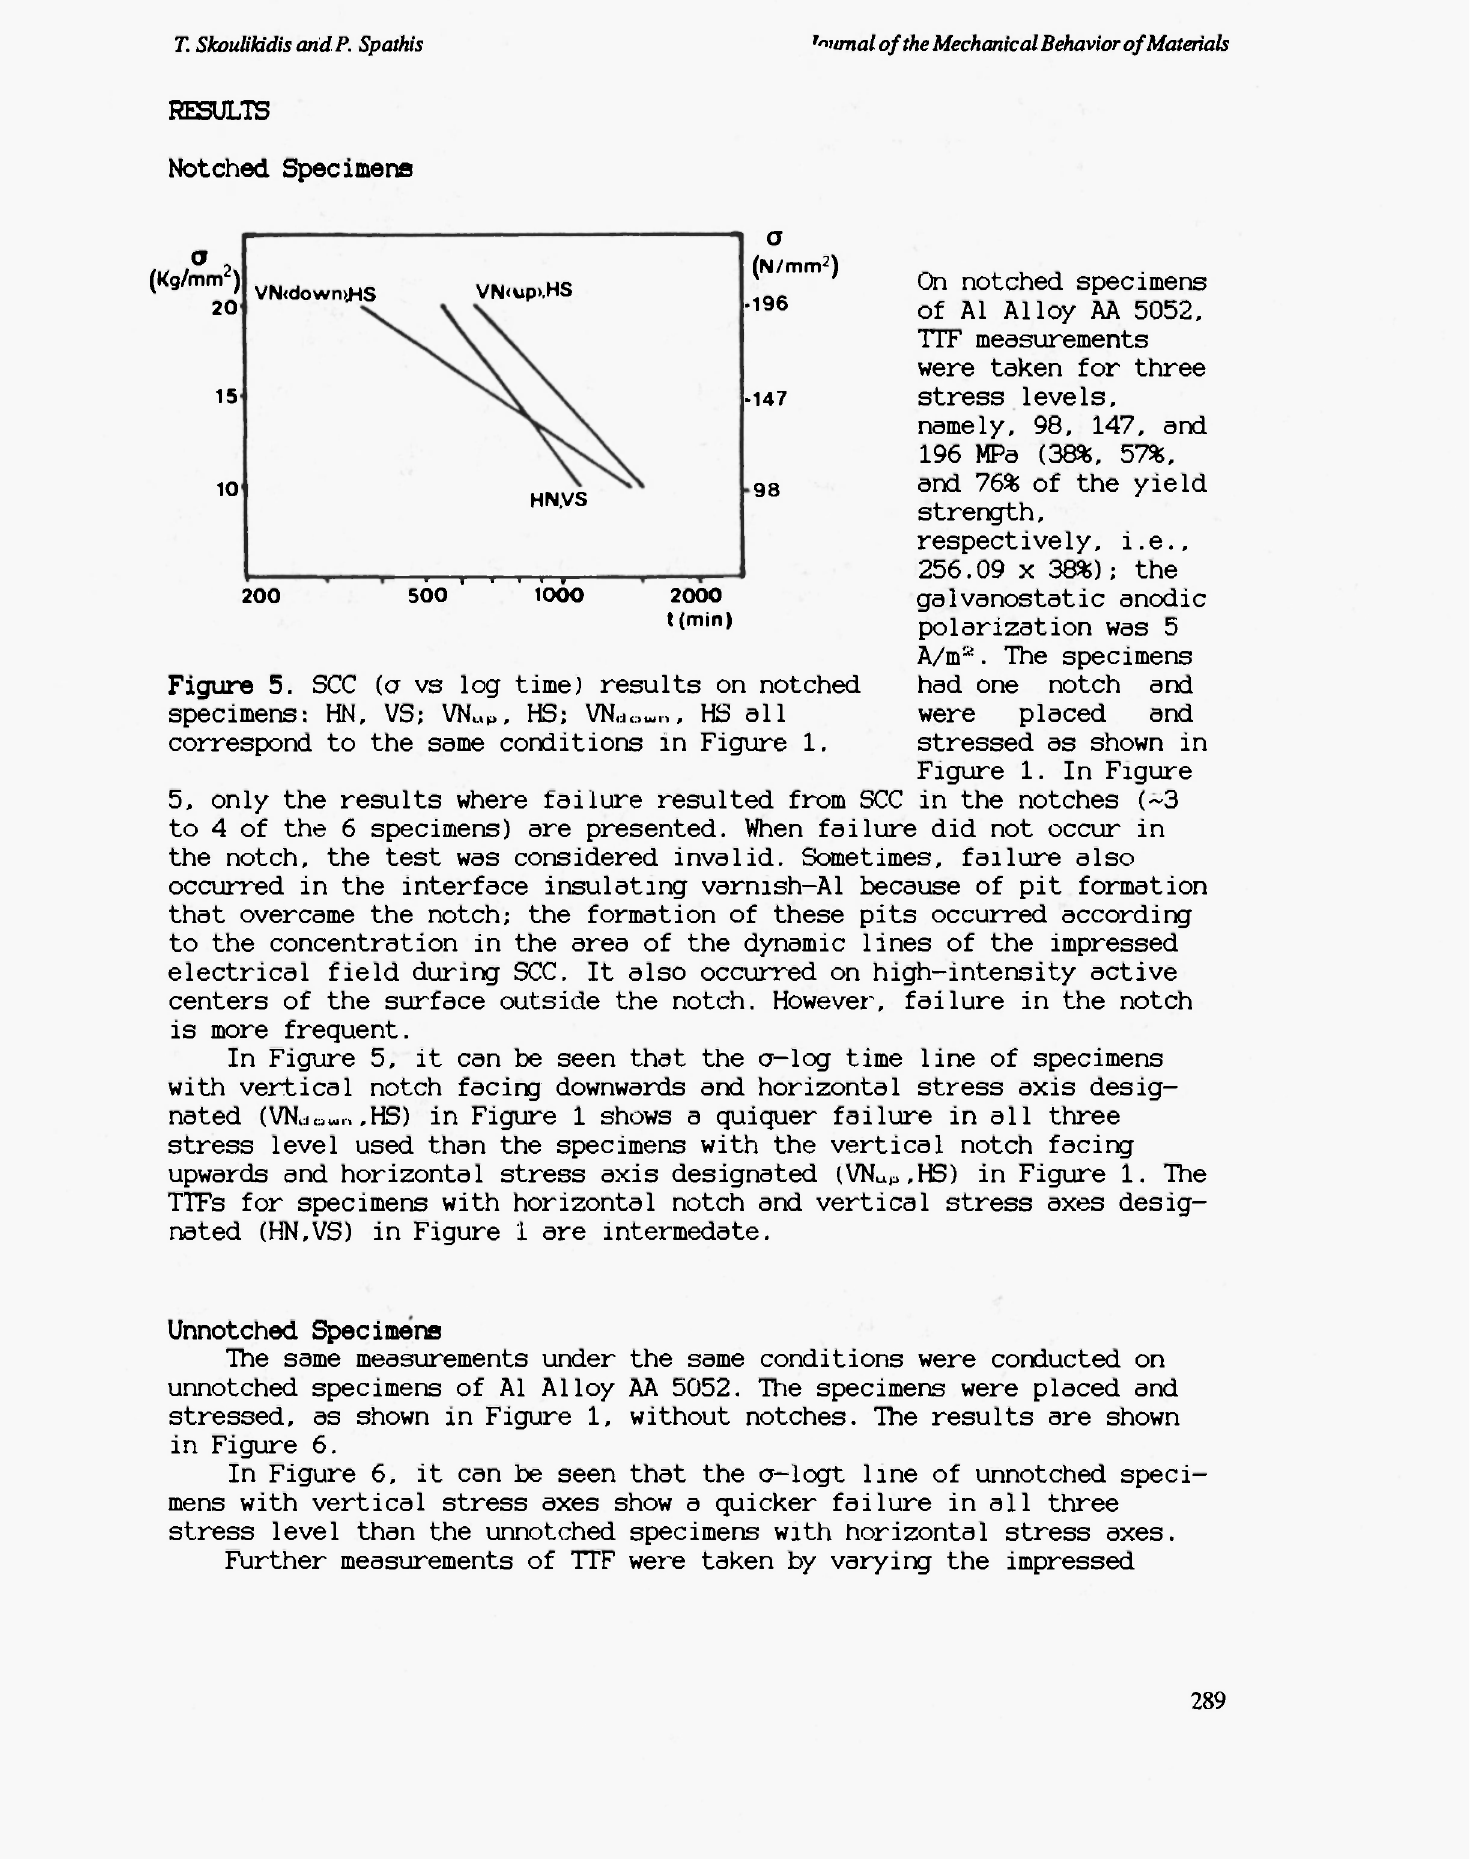
Figure 5. SCC (a vs log time) results on notched had one notch and specimens: HN, VS; VhL*. HS; VNdown, HS all were placed and correspond to the same conditions in Figure